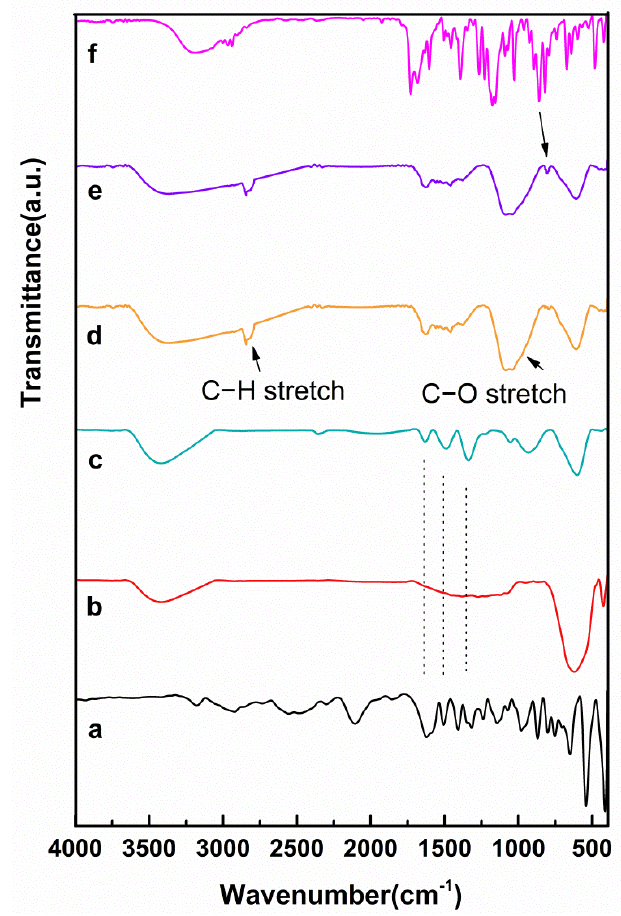
Figure 2. The FTIR spectra of ( a ) methionine, ( b ) Ni 1−x Co x Fe 2 O 4 NPs, ( c ) Ni 1 − x Co x Fe 2 O 4 @Methionine,